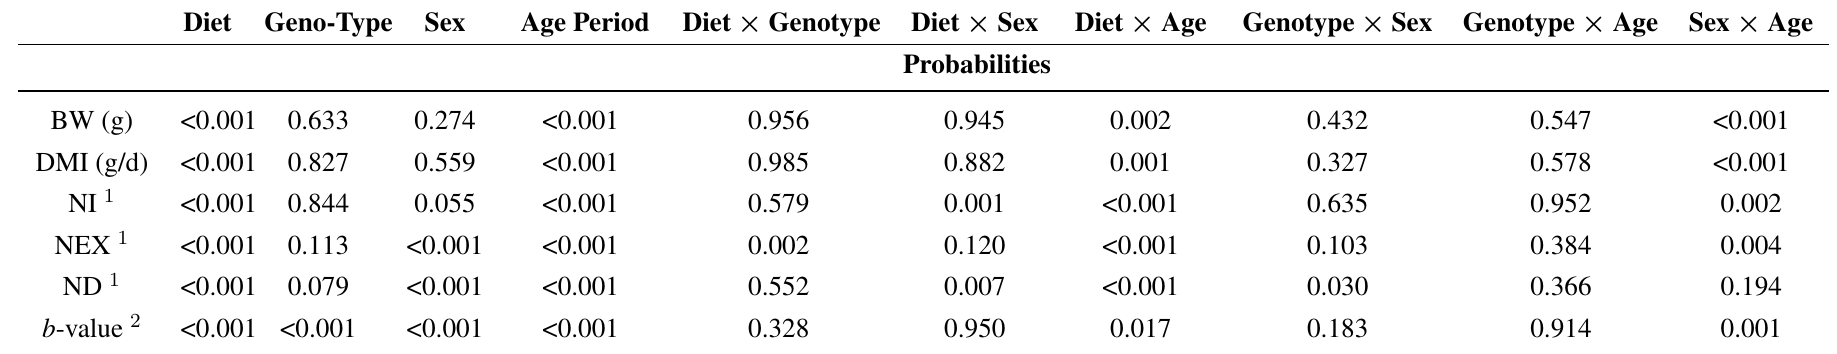
Table 3. Results derived from multi-factorial analysis of variance for all genotypes, sexes and age